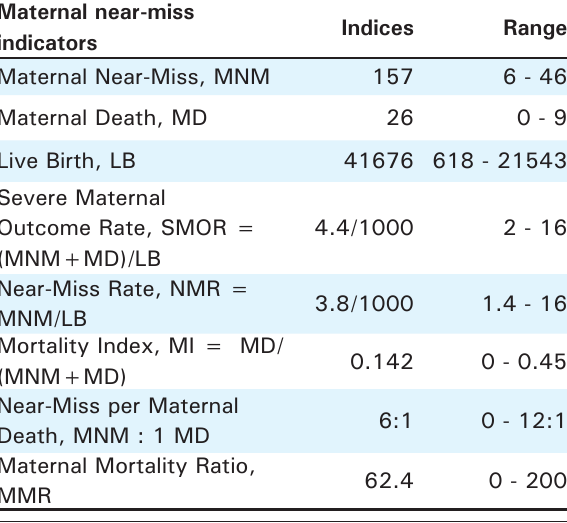
Table 1. Maternal near-miss indicators.